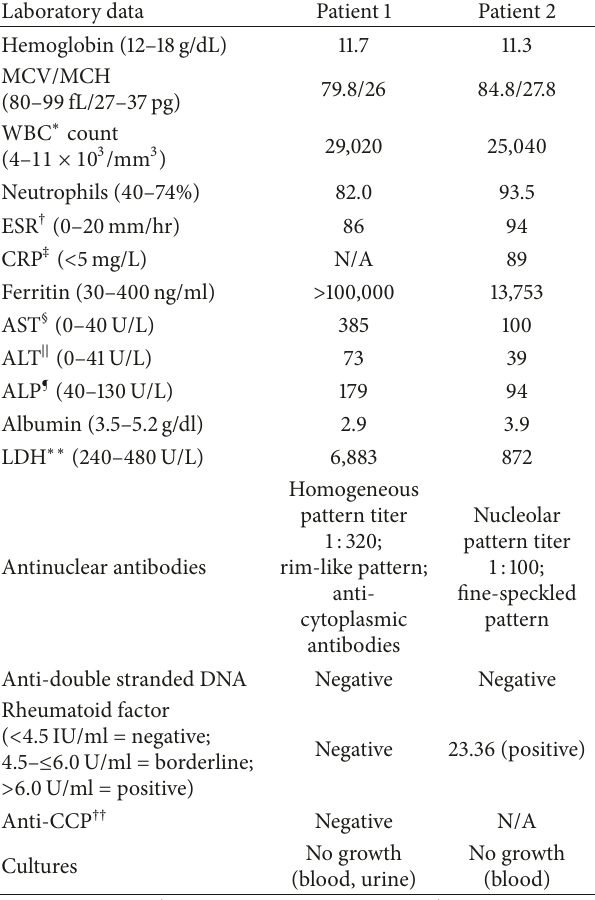
Table 1: Laboratory findings from two patients presenting with adult-onset Still’s disease.